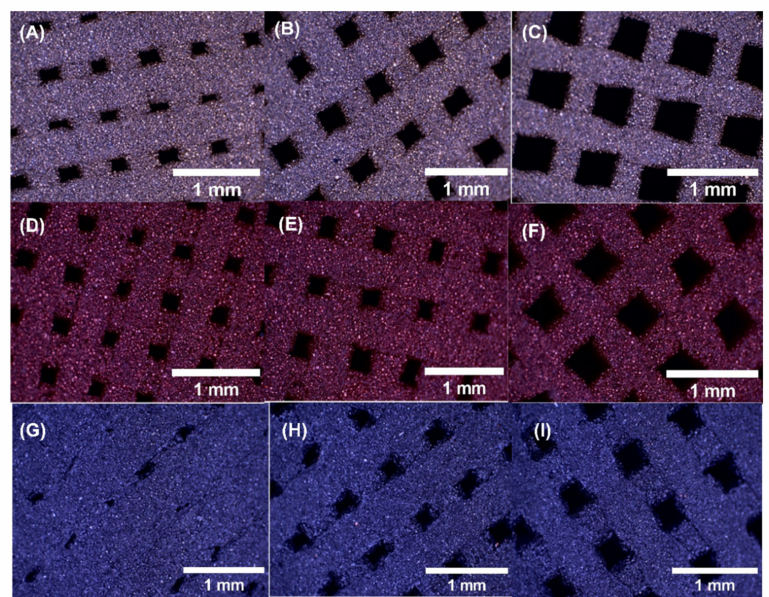
Figure 3. Surface of the samples with 16 × magnification: ( A ) bronze-filled 0.6 mm, ( B ) bronze-filled 0.7 mm, ( C ) bronze-filled 0.8 mm, ( D ) copper-filled 0.6 mm. ( E ) copper-filled 0.7 mm, ( F ) copper- filled 0.7 mm, ( G ) steel-filled 0.6 mm, ( H ) steel-filled 0.7 mm, ( I ) steel-filled 0.8 mm. The scale bars correspond to 1 mm.